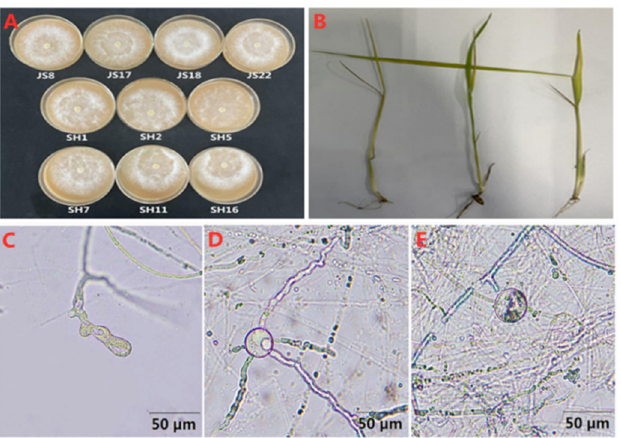
Figure 1. Pythium aristosporum causing rice seedling blight. ( A ) colony morphology of P. aristosporum isolates on V8 agar plates, ( B ) rice seedling blight caused by P. aristosporum , ( C ) sporangium, ( D ) oogonium, antheridium, ( E ) Oospore.